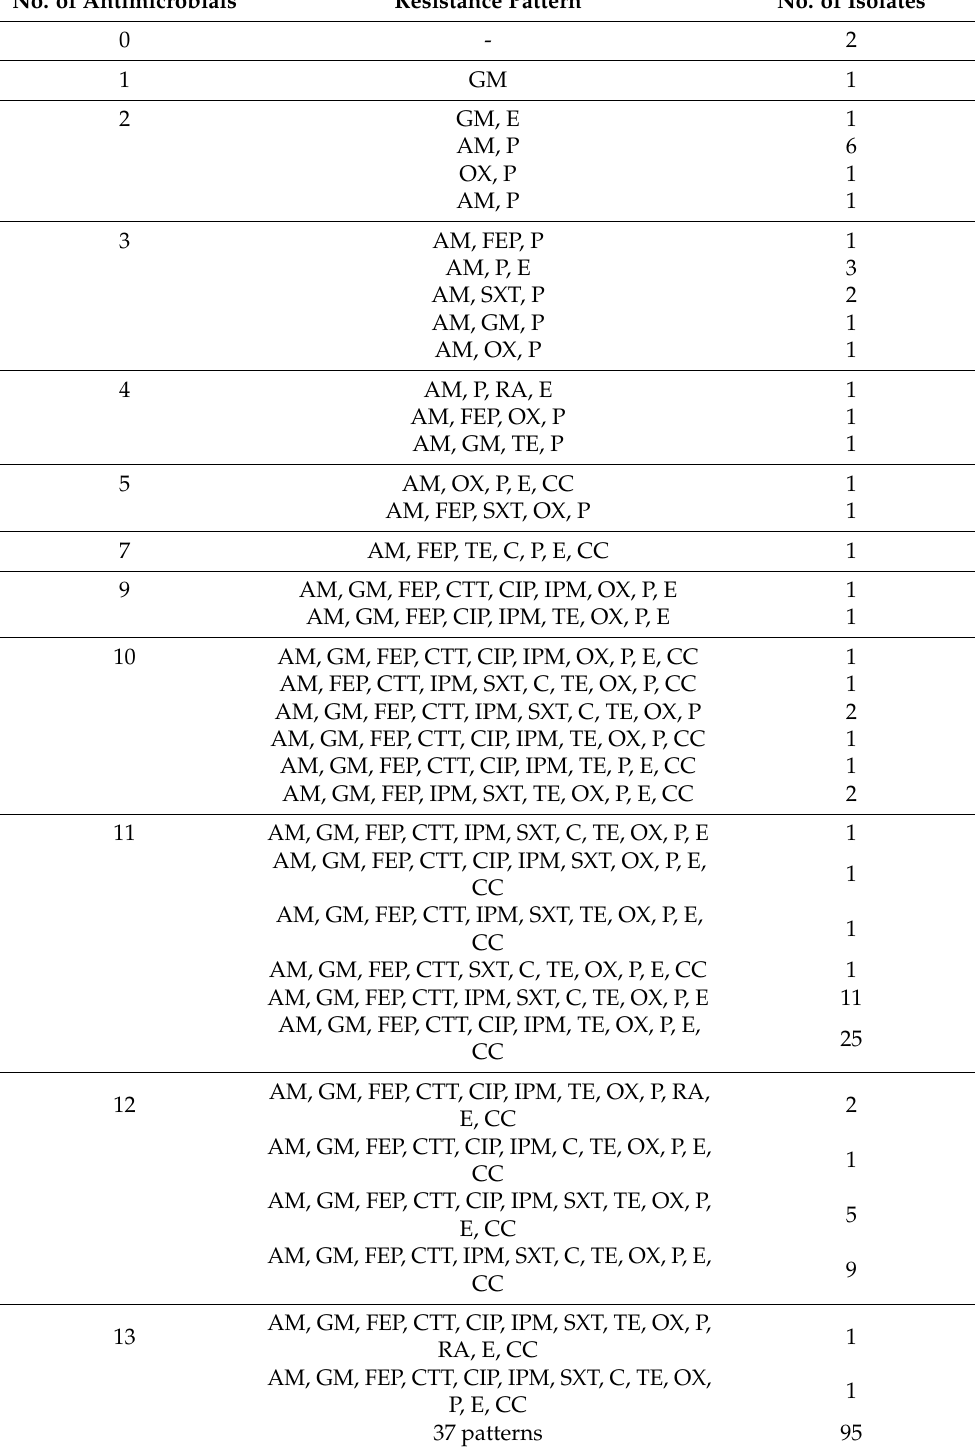
Table 3. Antimicrobial-agent resistance patterns of the 95 S. aureus stains. No. of